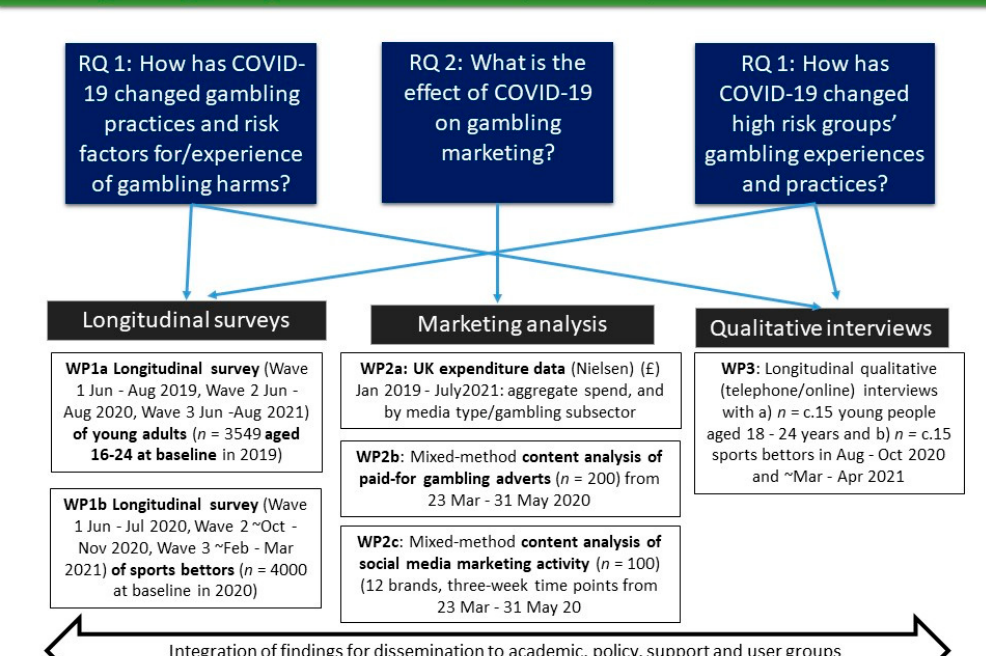
Figure 1. Overview of research questions and methods.